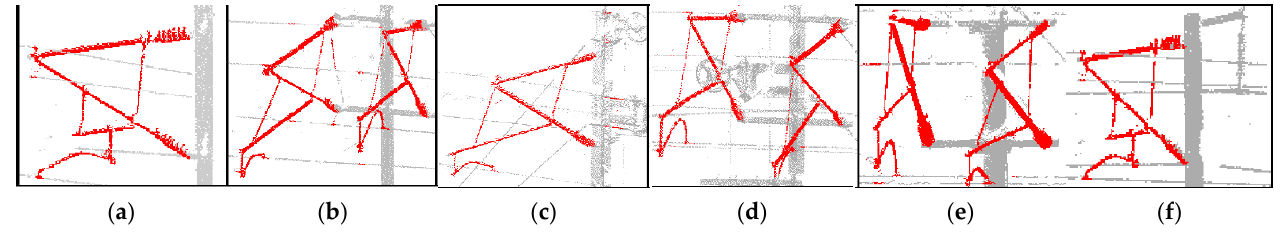
Figure 11. Extraction results of the six types of support devices: ( a ) the extracted result of the SSD, ( b ) the extracted result of the DSD, ( c ) the extracted result of the SRSD, ( d ) the extracted result of the DRSD, ( e ) the extracted result of the SFSD, and ( f ) the extracted result of the LSD. Table 3 and Figure 12 show the extraction effects of the three support device distri- bution scenes. The average IoU and F1 of the symmetric distribution scene were 95.89% and 97.88%, respectively. The average IoU and F1 of the asymmetric distribution scene were 94.49% and 97.15%, respectively. The average IoU and F1 of the adjacent distribution scenes are 92.49% and 96.05%, respectively. Because some of the insulators are filtered out, the IoU and F1 of SD5, SD6, and AD2 are substantially lower than the average symmetric and asymmetric distribution accuracy. In the neighboring distribution scene, the IoU and F1 of ND2 are well below the average accuracy due to the unfiltered slings between the adjacent support devices. Table 3. Quantitative extraction results.